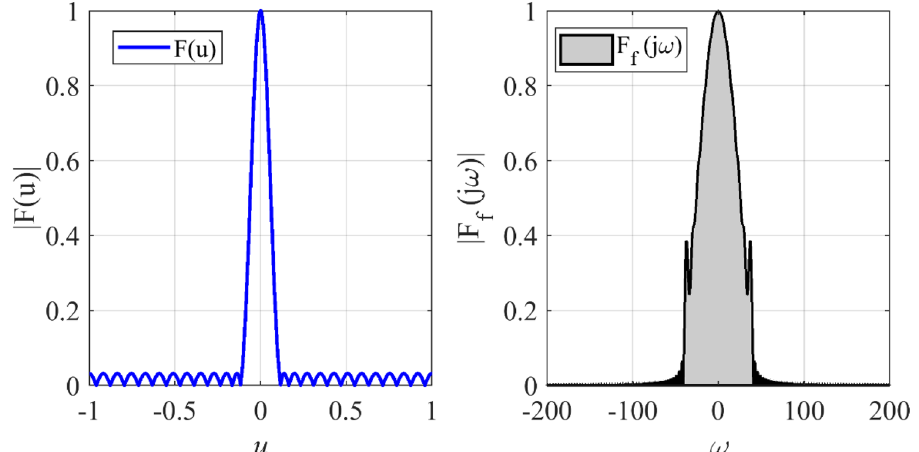
Figure 2. The desired pattern of the first case and its Fourier transform.